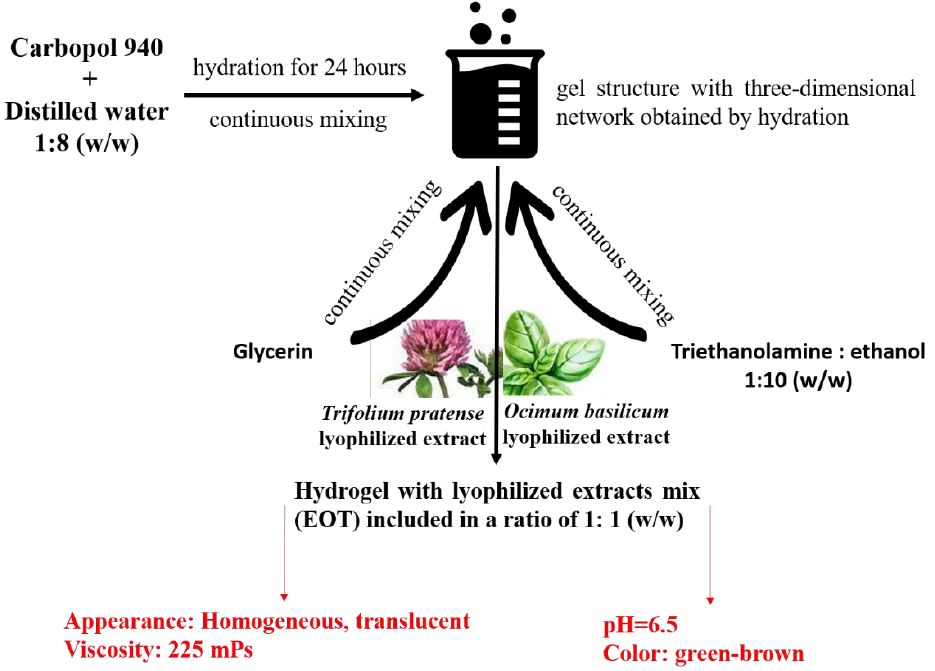
Figure 1. The preparation of gel formulation containing Trifolium pratense L. and Ocimum basilicum L. extract.